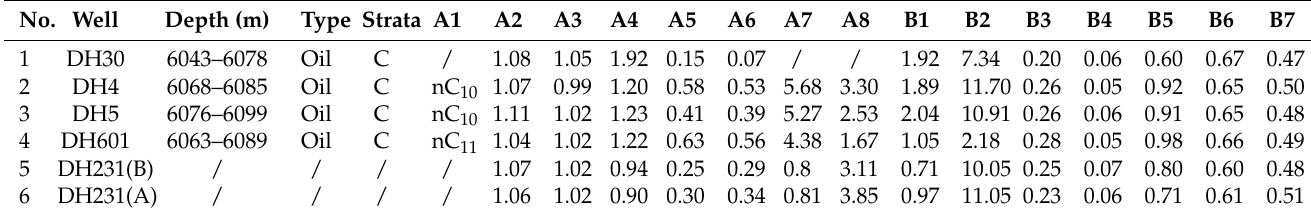
Table 3. Geochemical parameters of Ordovician crude oil and wellhead